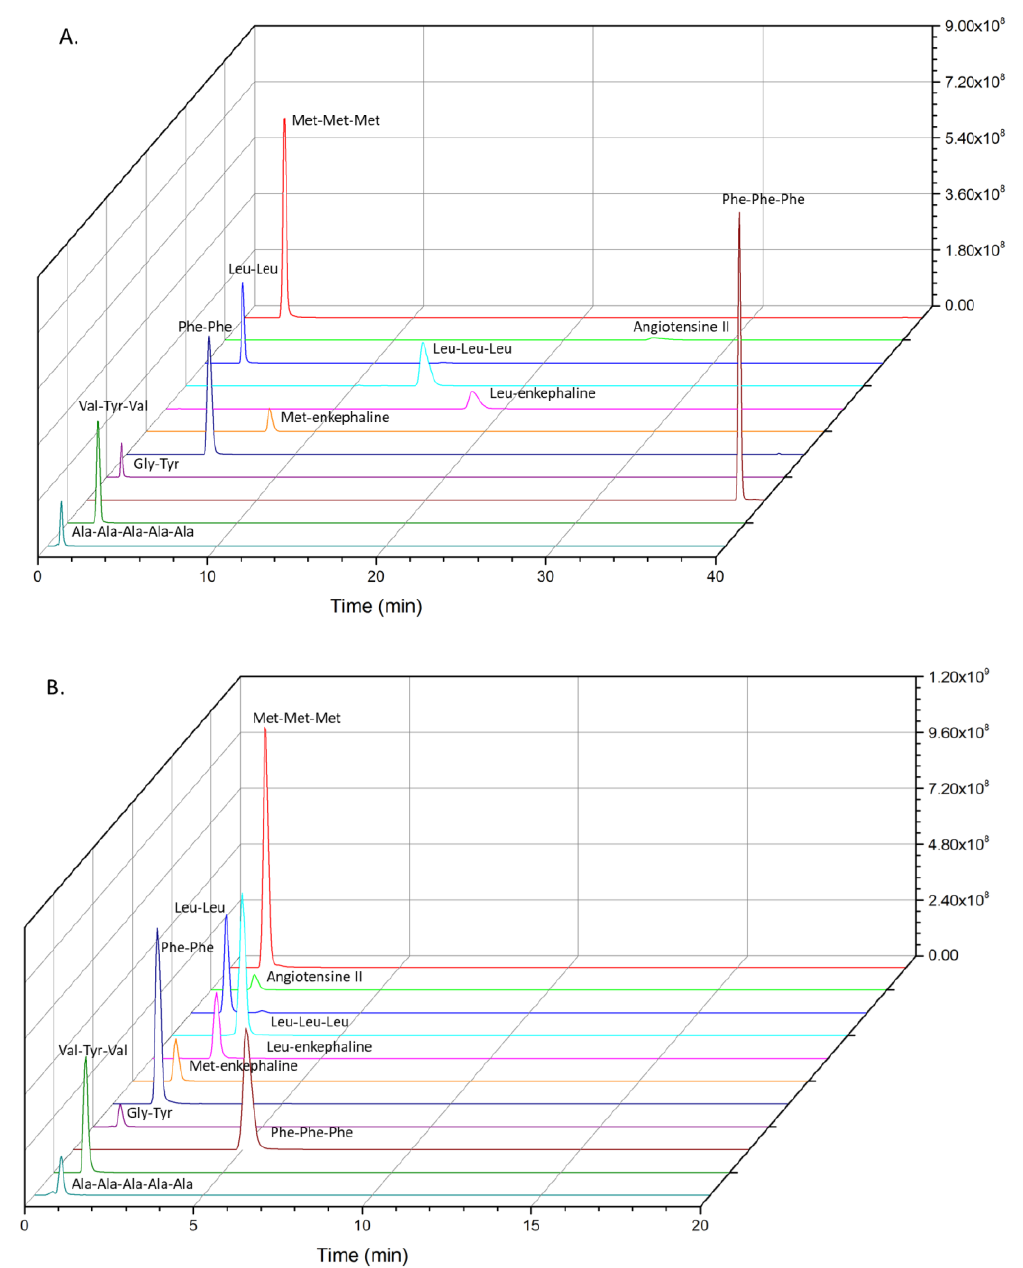
Figure 1. Direct injection extracted ion chromatogram: 20 µL of peptides solution (0.5 µg/mL) eluting on Hypersil Gold aQ (50 mm × 1 mm, 40 °C) with ( A ) 10/90 acetonitrile (ACN)/H 2 O and ( B ) 20/80 ACN/H 2 O as the mobile phase. Table 1. Retention times (min) of oligopeptides eluted on Hypersil Gold aQ (50 mm × 1 mm, 40 °C) with 10/90 ACN/H 2 O and 20/80 ACN/H 2 O as the mobile phase.